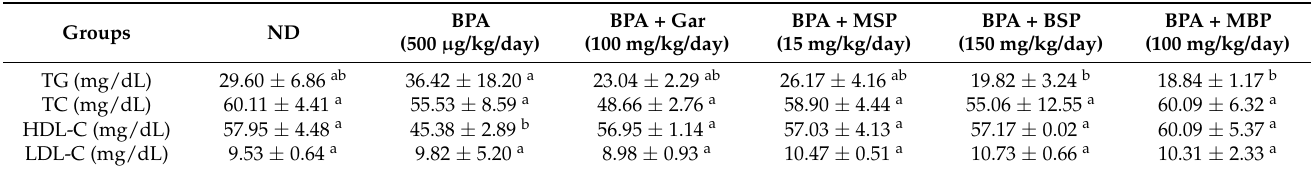
Table 1. Effects of MBP, BSP, and MSP on serum biochemistry in BPA-induced obese C57BL/6J mice.